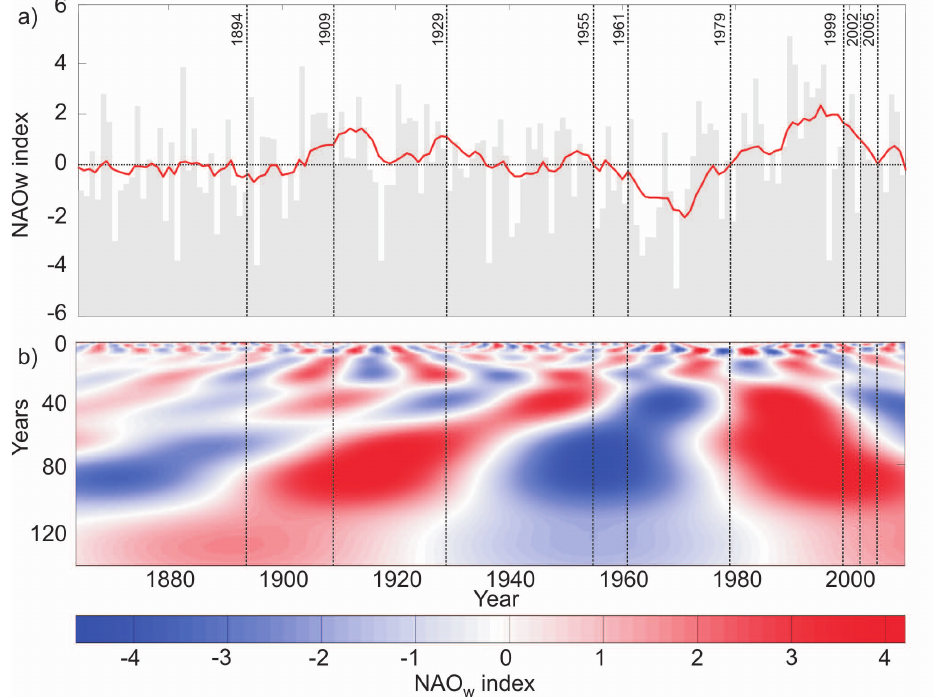
Fig. 5. (a) The monthly NAOw time-series (1864 to 2010) and the annual NAOw running average (red line). (b) Wavelet transform of the NAOw time-series (1864 to 2010). Vertical lines indicate the periods when rates of shoreline change are calculated.